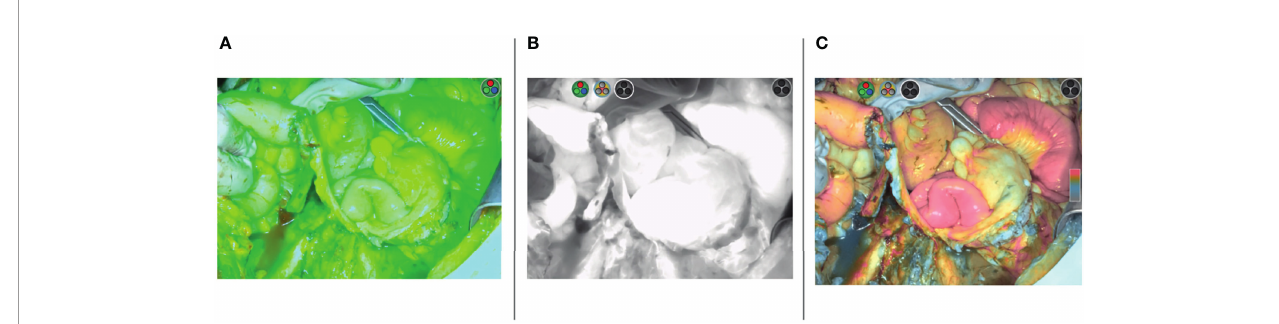
FIGURE 1 | Wallace ileal conduit uretero-enteric anastomoses indocyanine green (ICG) perfusion demonstrated with three different modalities: overlay fl uorescence mode (A) , contrast fl uorescence mode (B) , color segmented fl uorescence mode (C)